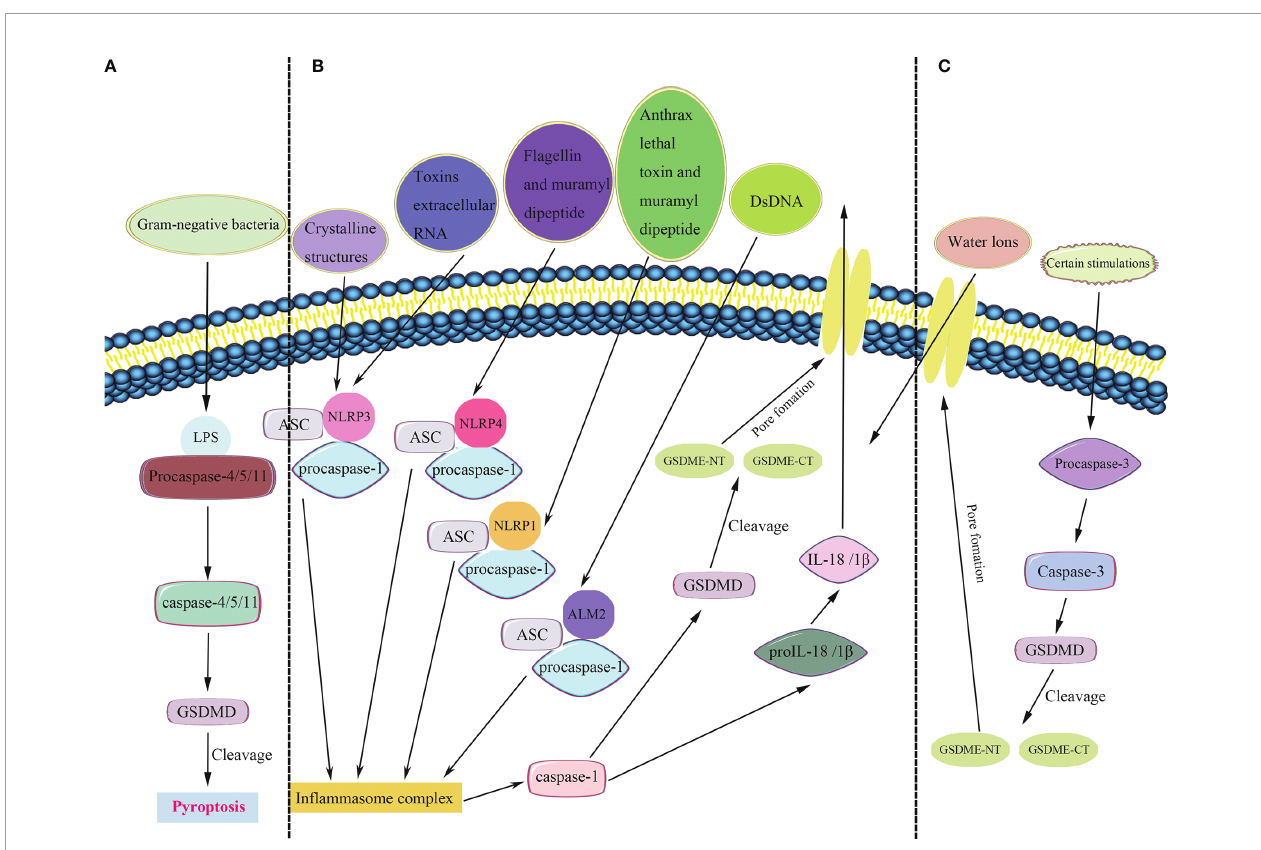
FIGURE 1 | Pyroptosis pathways. (A) In the non-canonical in fl ammasome pathway, bacterial lipopolysaccharide (LPS) recognizes and activates caspase-4/5/11 to cleave gasdermin D (GSDMD) and induce pyroptosis. (B) In the canonical in fl ammasome pathway, the in fl ammasomes recruit and bind to ASC (apoptosis- associated speck-like protein containing a CARD), leading to ASC focus, which in turn recruits procaspase-1 and activates caspase-1. Caspase-1 is involved in the cleavage and maturation of proIL-18/1 b and cleavage of GSDMD. The released N-terminal fragment of GSDMD (GSDMD-NT) creates pores in the plasma membrane, resulting in the secretion of IL-18/1 b and causing water in fl ux, and consequently cell swelling and osmotic lysis. The C-terminal fragment of GSDMD (GSDMD-CT) stays within the cytoplasm. (C) A new pyroptosis pathway revealed that certain stimulations activate caspase-3, a molecular considered as a substrate of apoptosis. Mature caspase-3 induces the cleavage of gasdermin E (GSDME), including its C-terminal and N-terminal fragments (GSDME-CT and GSDME-NT, respectively). Furthermore, GSDME-NT participants in the pore formation, resulting in